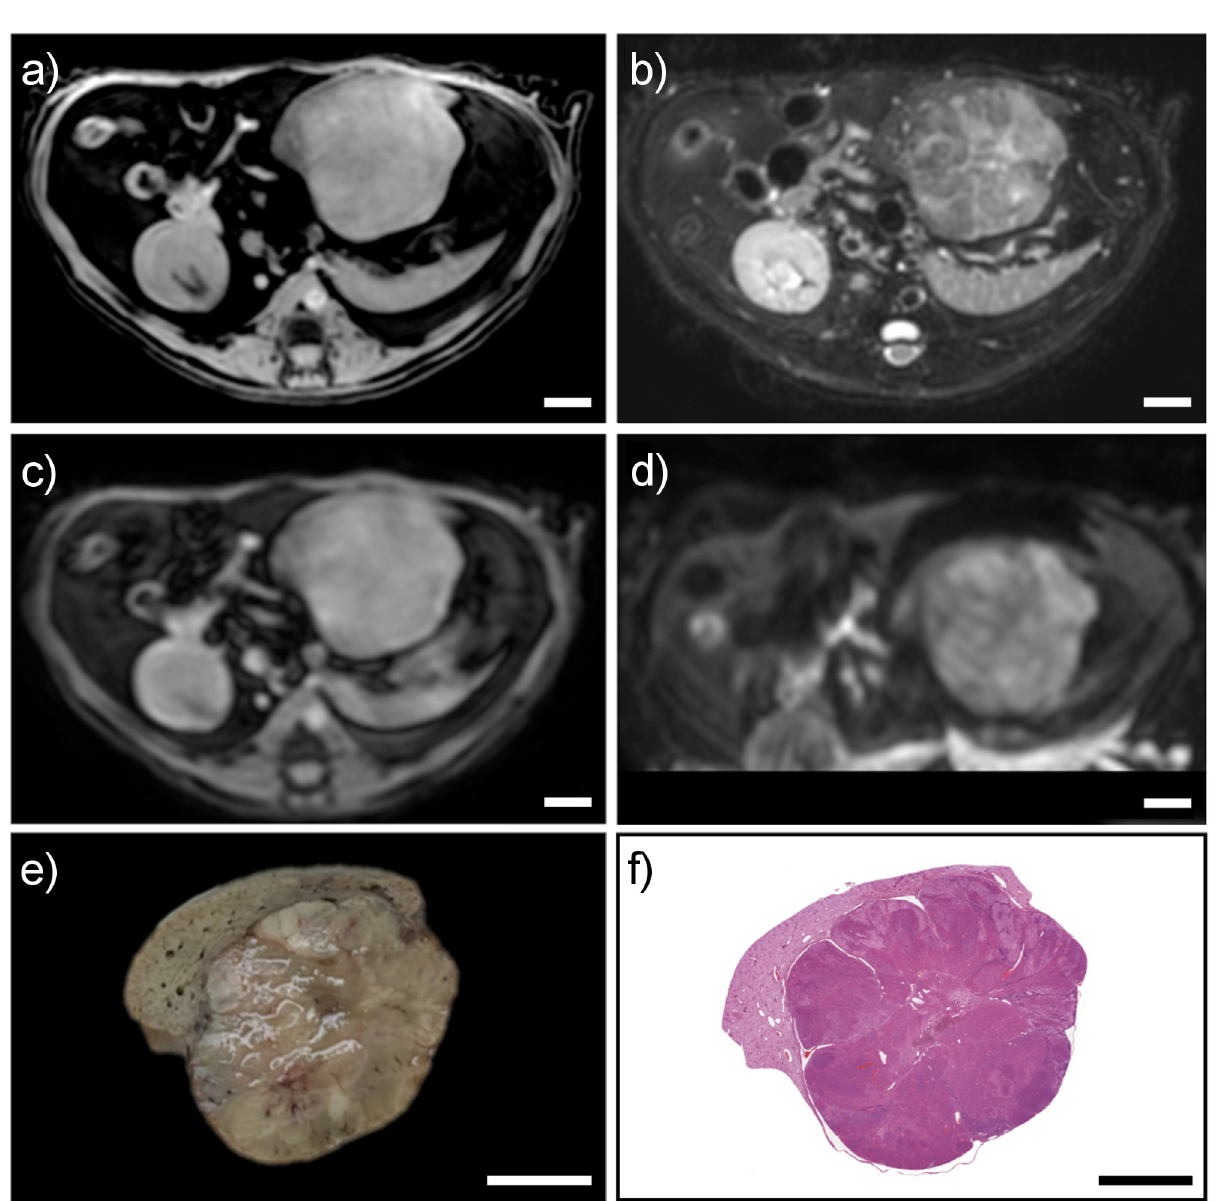
Fig 3. Corresponding in vivo MRI, gross pathology, and histopathology for a section from a formalin-fixed specimen. Multiple in vivo MRI sequences showing a large hepatic tumor, including: (A) T1 High Resolution Isotropic Volume Excitation (THRIVE), B) T2-weighted turbo spin echo, (C) dynamic contrast-enhanced, and (D) diffusion-weighted imaging. Formalin-fixed gross pathology section from the mold (E) with corresponding histopathology section (F) corresponding to slice location in MR images. Scale bars represent 1